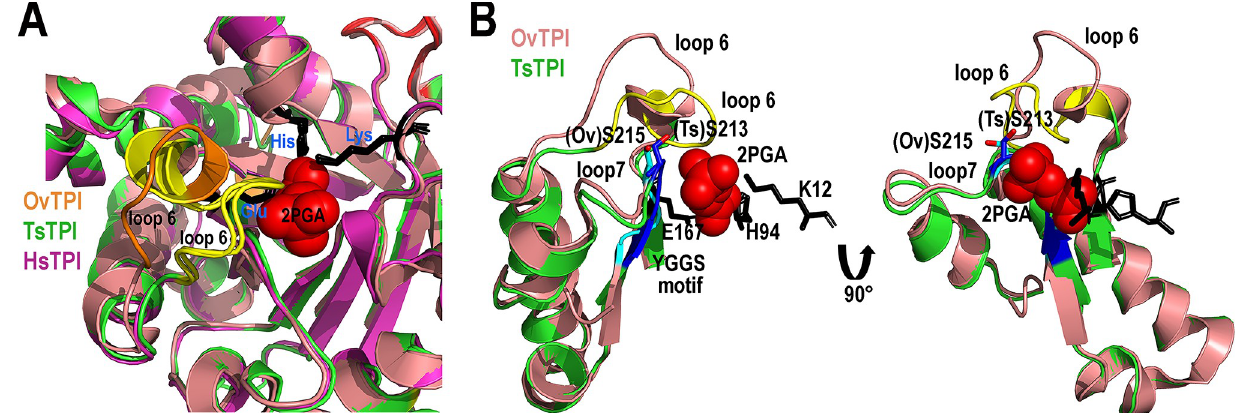
Fig 3. Closed and open conformations of TPIs from helminths. A) Close-up view of the active site of TsTPI and SmTPI in comparison to OvTPI. Structural alignments of TPIs from helminths solved in the presence of 2-PGA (TsTPI and SmTPI) and in its absence (OvTPI). The loop 6 and β -stand 7 of TsTPI and SmTPI are colored in yellow, whereas in OvTPI these structural elements are colored in orange. The conformational change in loop 6 results from a hinge motion in the presence of substrate. B) Substrate binding assembles the active site in helminth TPIs. Ribbon representation of residues corresponding to loops 6 and 7 in OvTPI and TsTPI. The figure illustrates the positions of residues TsTPI-S213 and SmTPI-S215. The position of the conserved YGGS motif of the phosphate binding loop are colored in blue and cyan. The active site amino acids of TsTPI are in a ball-stick representation and black